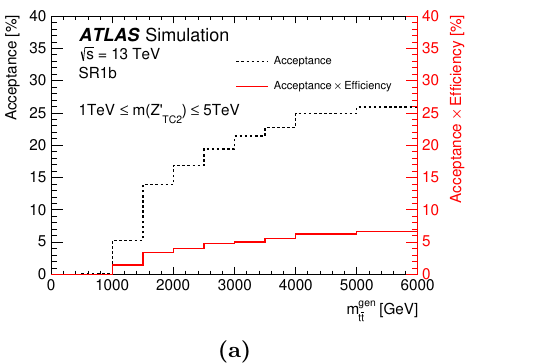
Figure 1. Normalized m reco of 2, 3, 4 and 5 TeV for (a) SR1 b and (b) SR2 b .